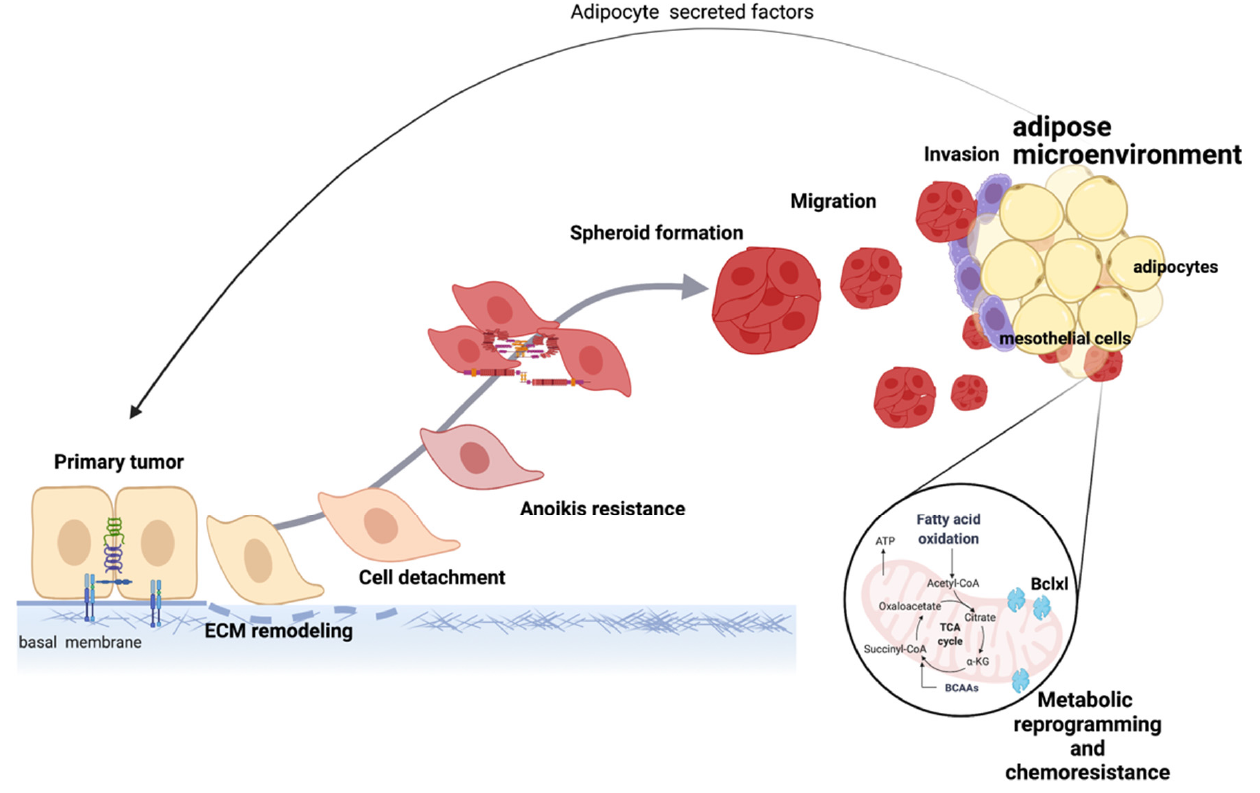
Figure 4. Mechanisms induced by the adipose microenvironment support ovarian tumor progression. Secreted factors from adipocytes and direct cell-to-cell contact between adipocytes and ovarian cancer cells lead to EMT, metabolic reprogramming, and acquisition of chemoresistance, which collectively support disease progression. Created with Biorender.com (accessed on 1 April 2022).